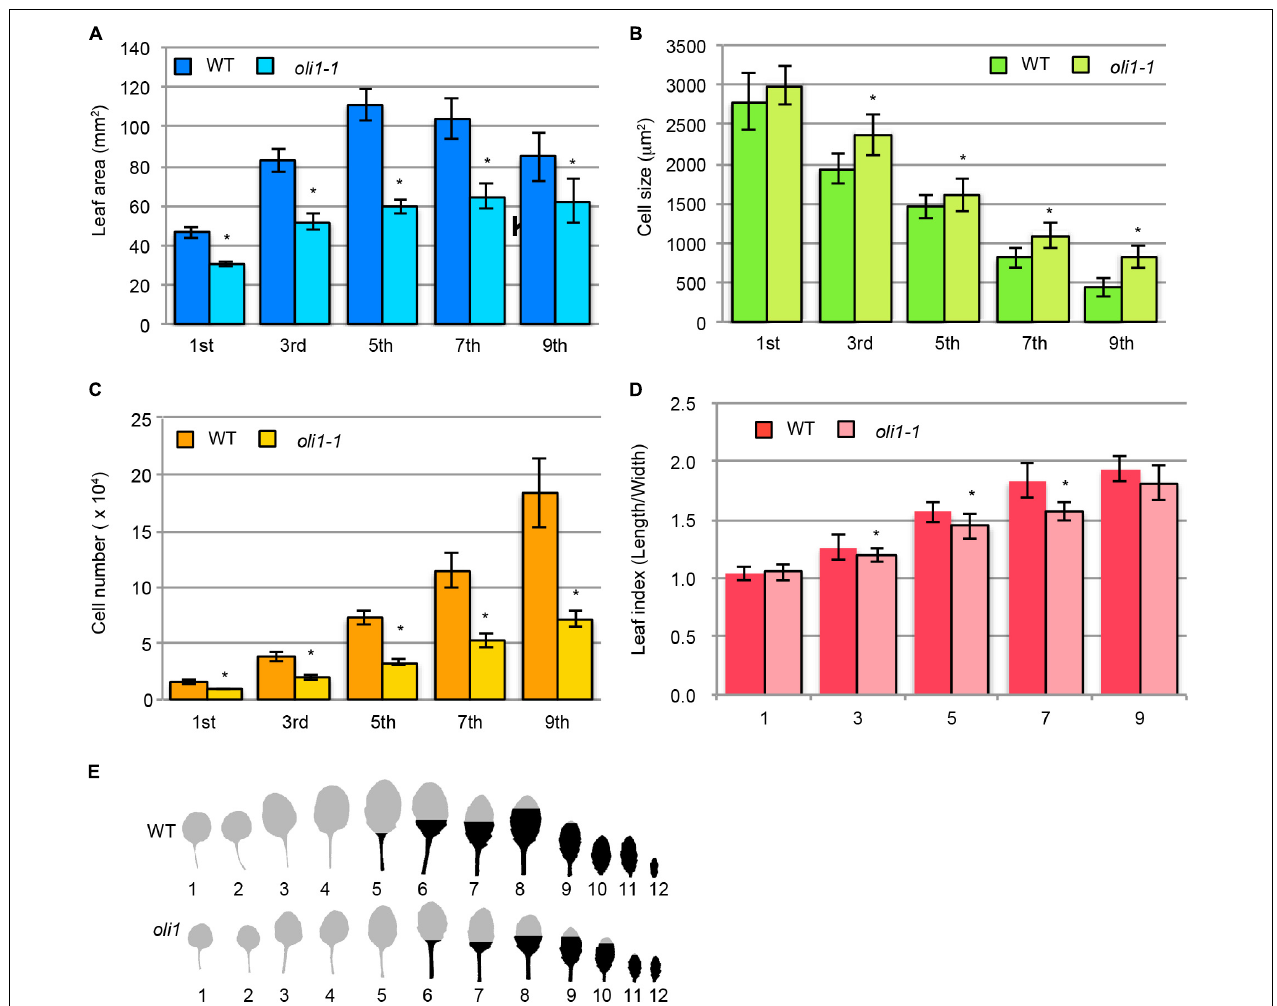
FIGURE 2 | Characterization of leaf phenotypes during the transition from the juvenile to adult phases in oli1-1 . (A) Leaf blade areas. (B) Projection areas of palisade cells. (C) Estimated palisade cell numbers. (D) Leaf index (the ratio of leaf blade length to width). The data are shown as means ± SD ( n = 10), and asterisks indicate statistically significant differences between WT and oli1-1 (Student’s t -test; p < 0.05). (E) Distribution of abaxial trichomes. A portion of the leaf blades is filled in black to indicate the upper limit of the abaxial trichome distribution. The trichome distribution was observed using 31-day-old plants. In (A–D) , the first and third, fifth and seventh, and ninth leaves were harvested at 24, 27, and 31 days after sowing, respectively. In (A–E) , the leaf positions were numbered from the oldest leaves on the bottom row of each